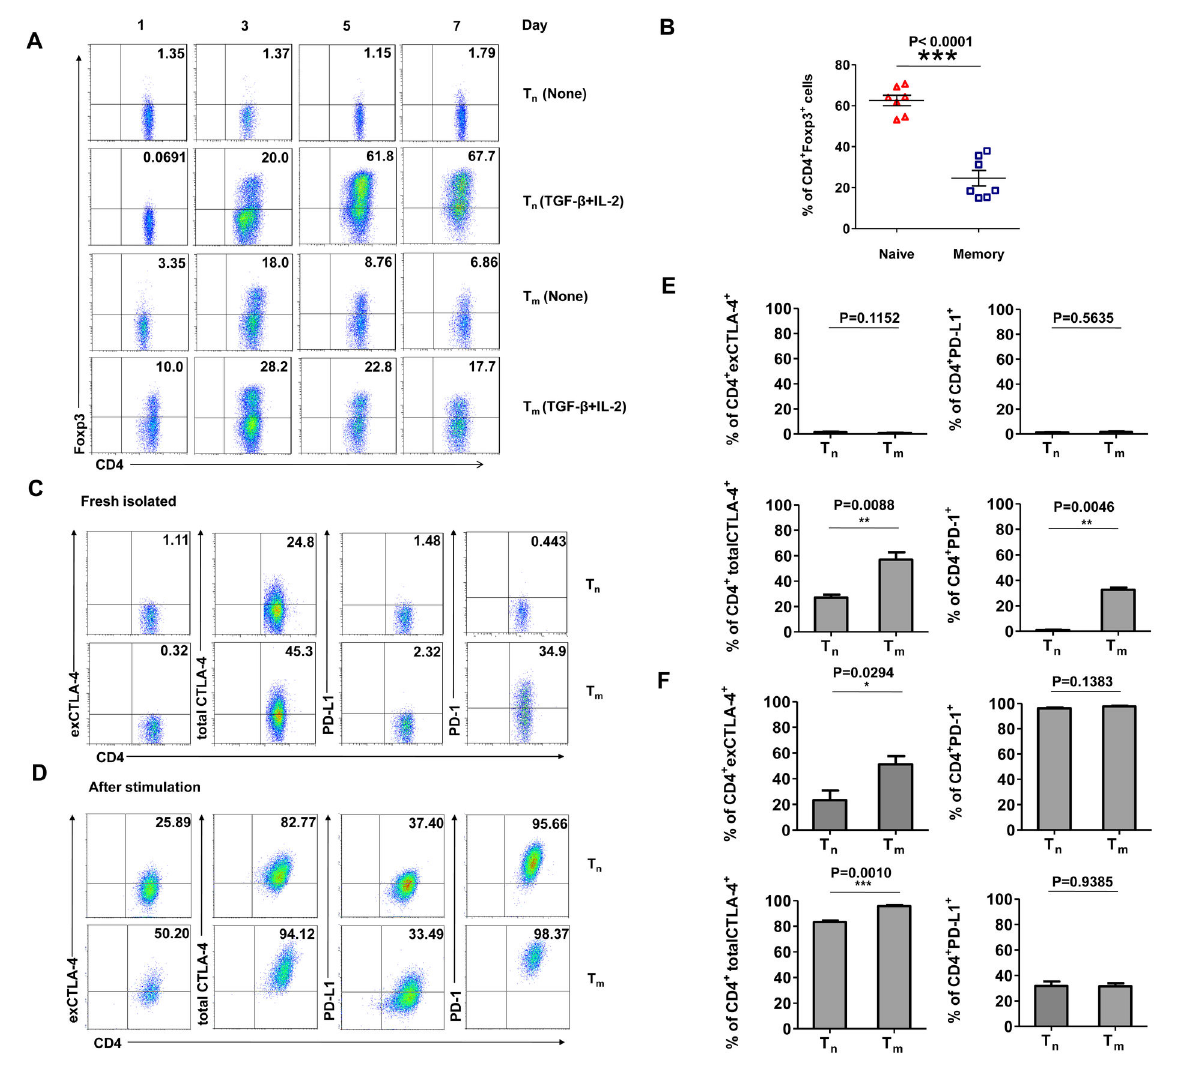
Figure 2. Small portion of human CD4 + memory T cells can be converted to Foxp3 + T cells in vitro . (A) CD4 + naive (Tn) and memory (Tm) T cells were sorted and activated with plate-bound anti-CD3 (5 μg/ml) and soluble anti-CD28 (1 μg/ml) in the presence or absence of TGF-β (5 ng/ml) and IL-2 (100 UI/ml). Foxp3 expression was analysed by flow cytometry at different time points as indicated. (B) The average percentages of Foxp3 expression in CD4 + naive and memory T cells on day 5 after TGF-β and IL-2 induction. (C) and (E) Flow cytometric analysis of CTLA-4 (extracellular and total), PD-1, and PD-L1 expression in total, freshly sorted, naive (Tn) or memory (Tm) CD4 + T cells. (D) and (F) Sorted CD4 + naive (Tn) or memory (Tm) T cells were activated for 5 days as described above, and the total population was analysed using flow cytometry for the expression of CTLA-4 (extracellular and total), PD-1, and